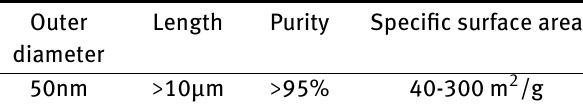
Table 2: Properties of the MWCNT used in this study.